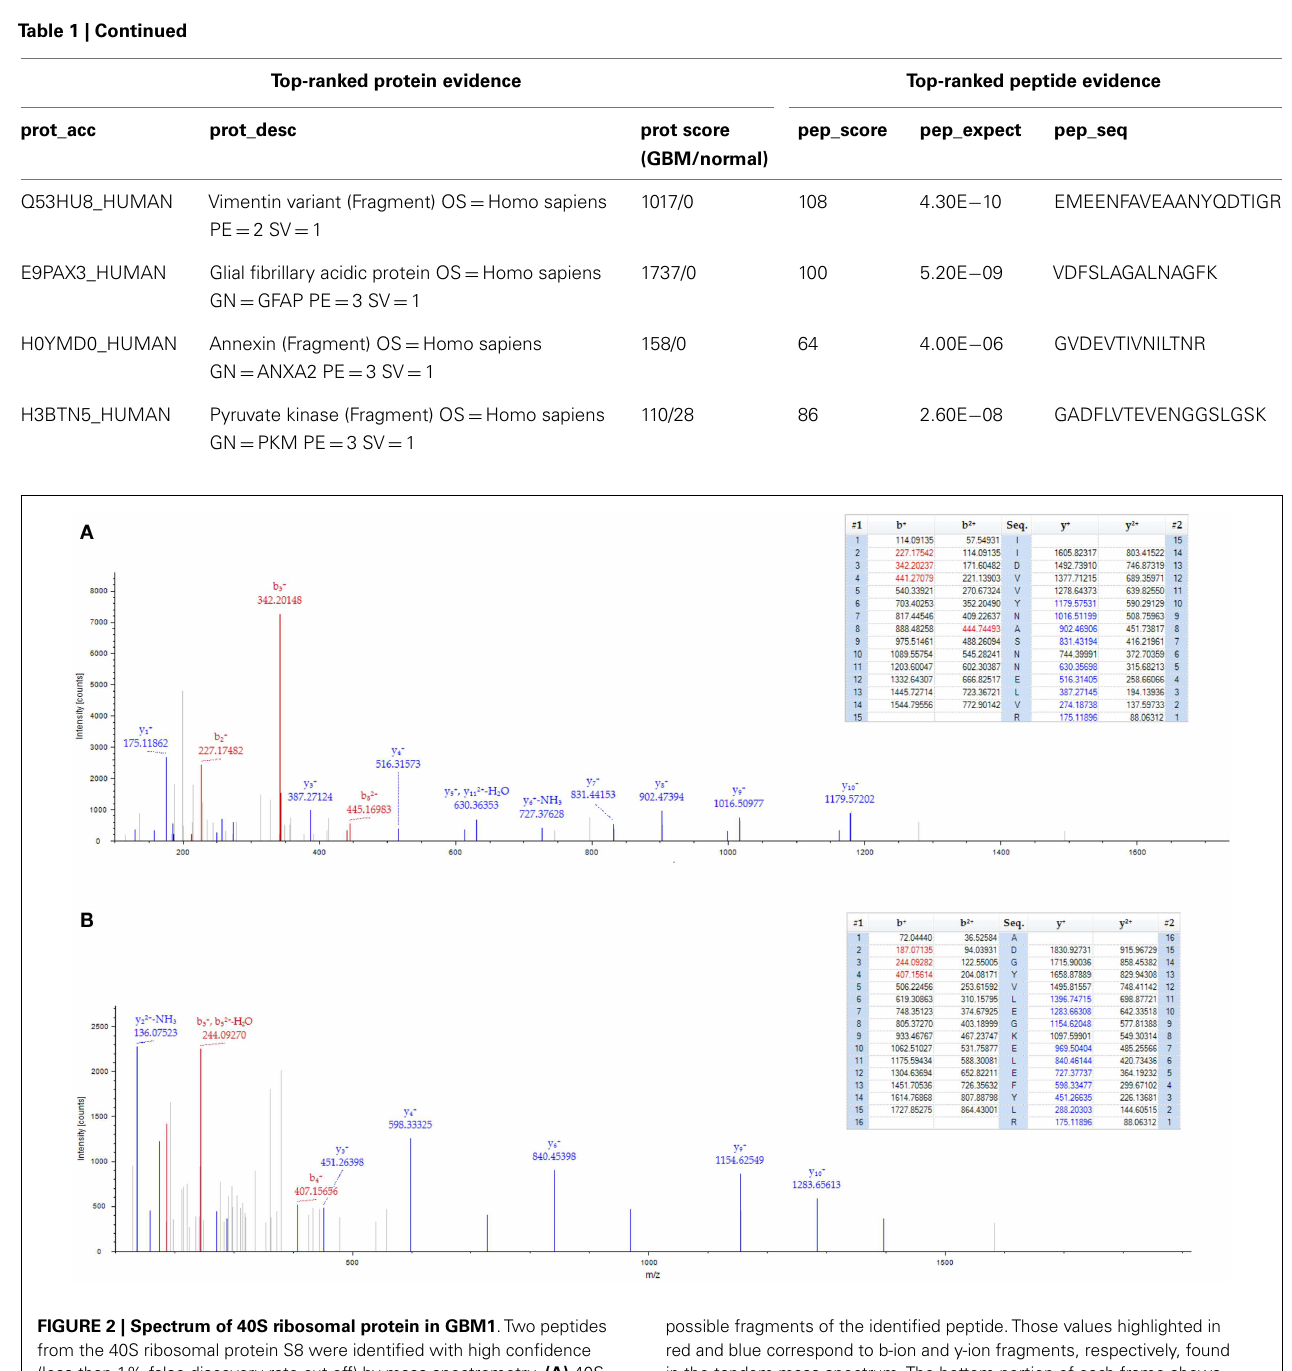
FIGURE 2 | Spectrum of 40S ribosomal protein in GBM1 .Two peptides from the 40S ribosomal protein S8 were identified with high confidence (less than 1% false discovery rate cut-off) by mass spectrometry. (A) 40S ribosomal protein S8 peptide sequences (IIDVVYNASNNELVR). (B) 40S ribosomal protein S8 peptide sequences (ADGYVLEGKELEFYLR).The top portion of each frame shows the predicted b- and y-ions values ( m / z ) for